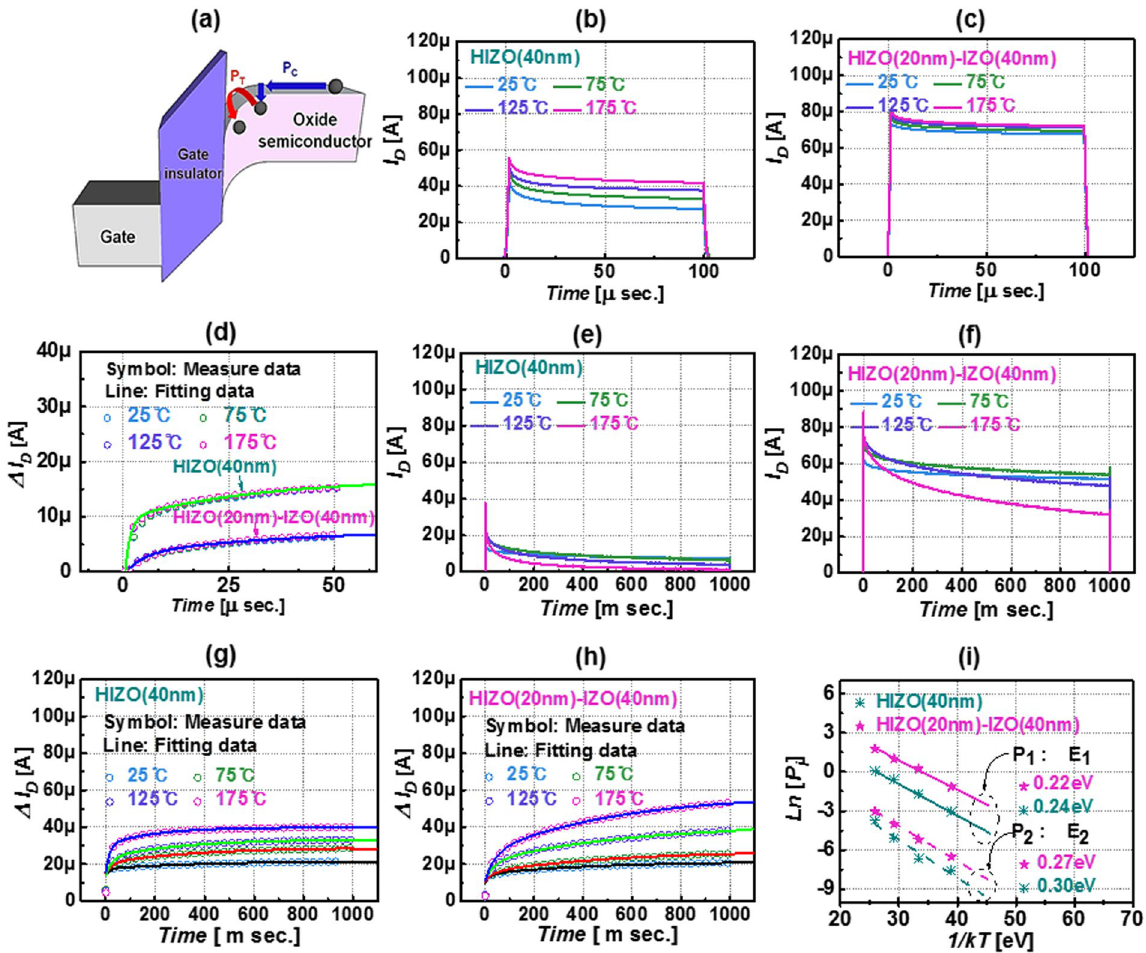
Figure 5. ( a ) Transient charge trapping model in oxide semiconductor TFT. ( b , c ) Representative transient current data of HIZO and HIZO-IZO oxide TFTs at different measurement temperatures (25 to 175 °C) during the short pulse of 100 μ s. ( d ) Experimental (symbol) and modeled (line) drain current change for 50- μ s short pulse time for both devices. Transient current data of ( e ) HIZO and ( f ) HIZO-IZO oxide TFTs during the relatively long pulse time (1000 ms). Experimental (symbol) and modeled (line) transient current reduction of ( g ) HIZO and ( h ) HIZO-IZO oxide TFTs. ( i ) Activation energies E i extracted from charge trapping probability, p i values versus measurement temperature for both oxide